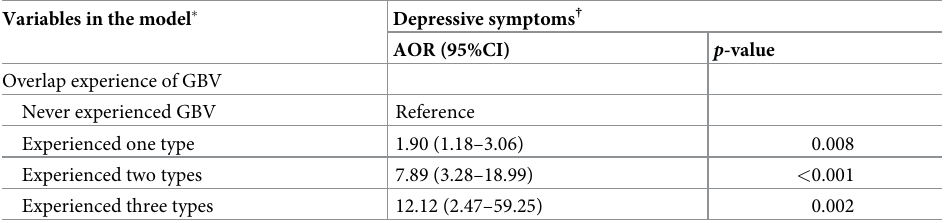
Experienced three